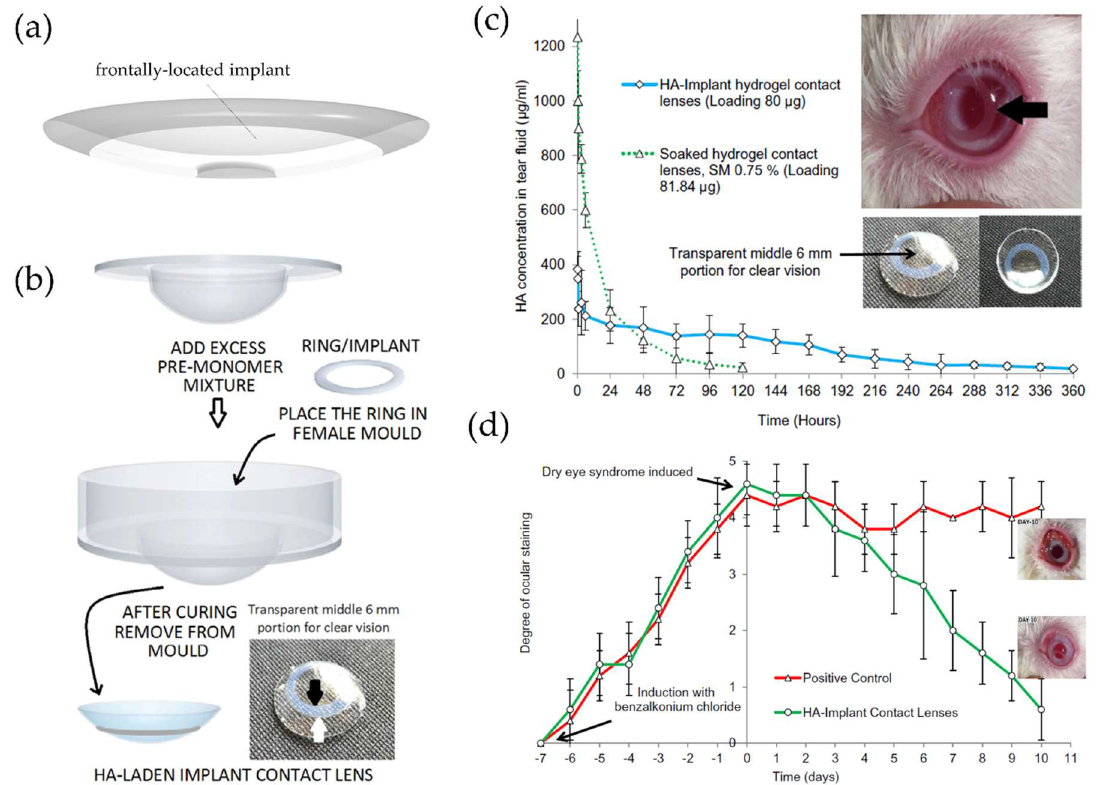
Figure 5. ( a ) Schematic of therapeutic contact lenses embedded with frontally-located implant; ( b ) Schematic of the fabricating process of contact lenses embedded with an HA-laden implant (Blank arrow: inner margin of the implant, white arrow: outer margin of the implant); ( c ) hyaluronic acid (HA) release profile in tear fluid after wearing sterilized HA implant contact lenses and soaked contact lenses on rabbit eyes; ( d ) changes of ocular staining levels in dry eye disease-induced rabbit eyes by benzalkonium chloride treated with HA-implant contact lenses. Reprinted with permission from [66].